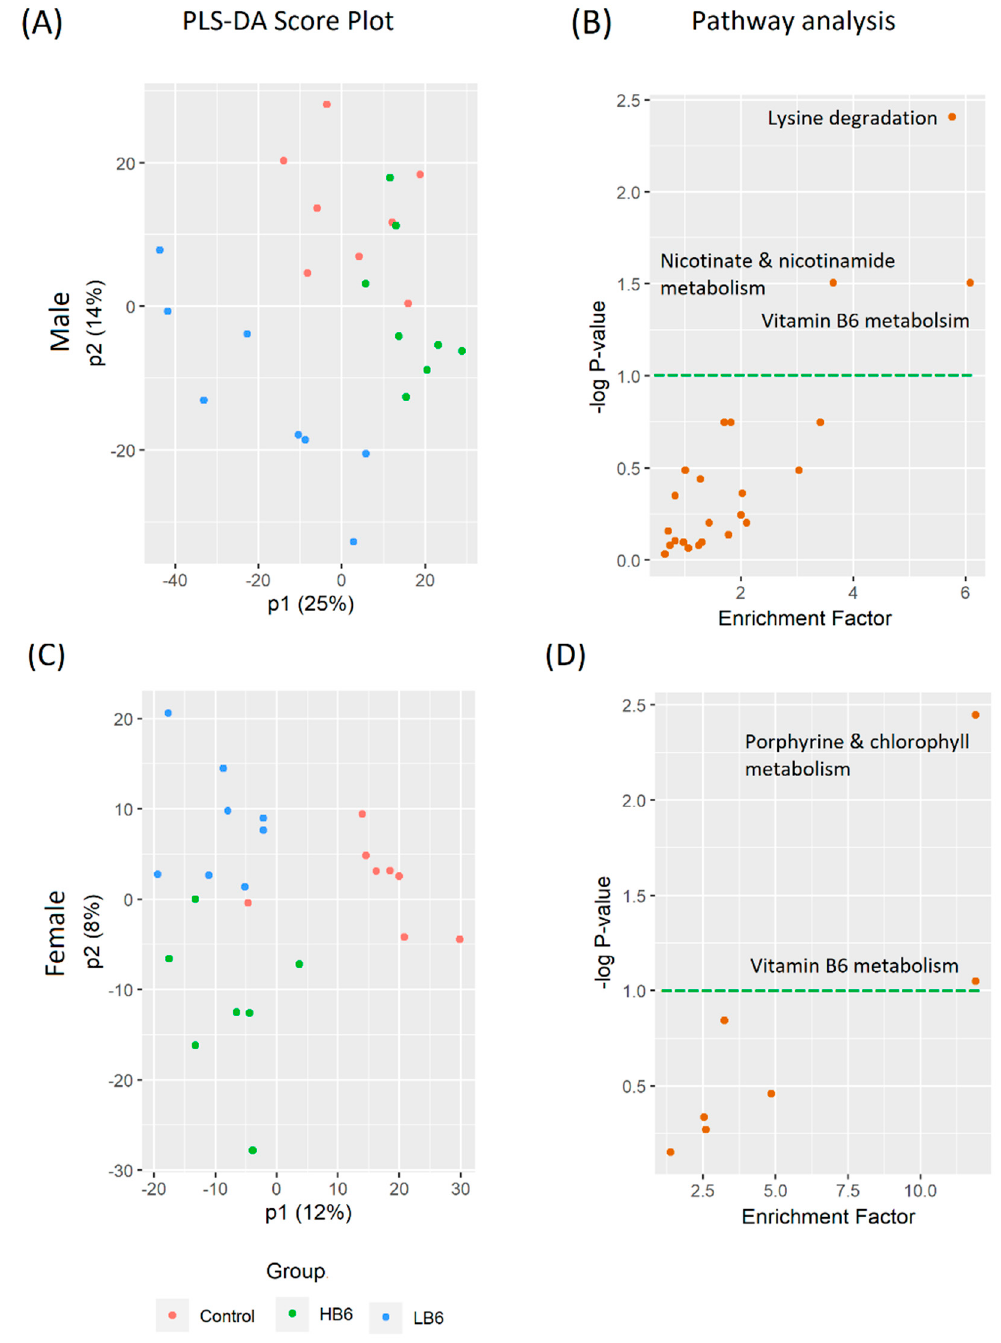
Figure 5. Serum metabolites that differ in LB6 rats compared to control and HB6 rats ( n = 8/group). Partial least square-discriminant analysis (PLS-DA) score plot for male ( A ) (R2Y = 0.533, Q2Y = 0.276, p < 0.05) and female ( C ) (R2Y = 0.674, Q2Y = 0.133, p < 0.05) metabolites with their corresponding affected metabolic pathways modulated in LB6 male ( B ) and female ( D ) rats compared to the control. n = 7–8/group of each sex.